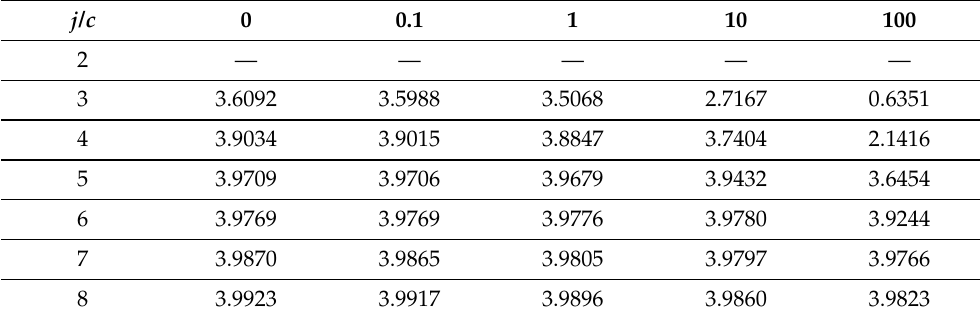
Table 2. Factors of condition numbers between level j and j −